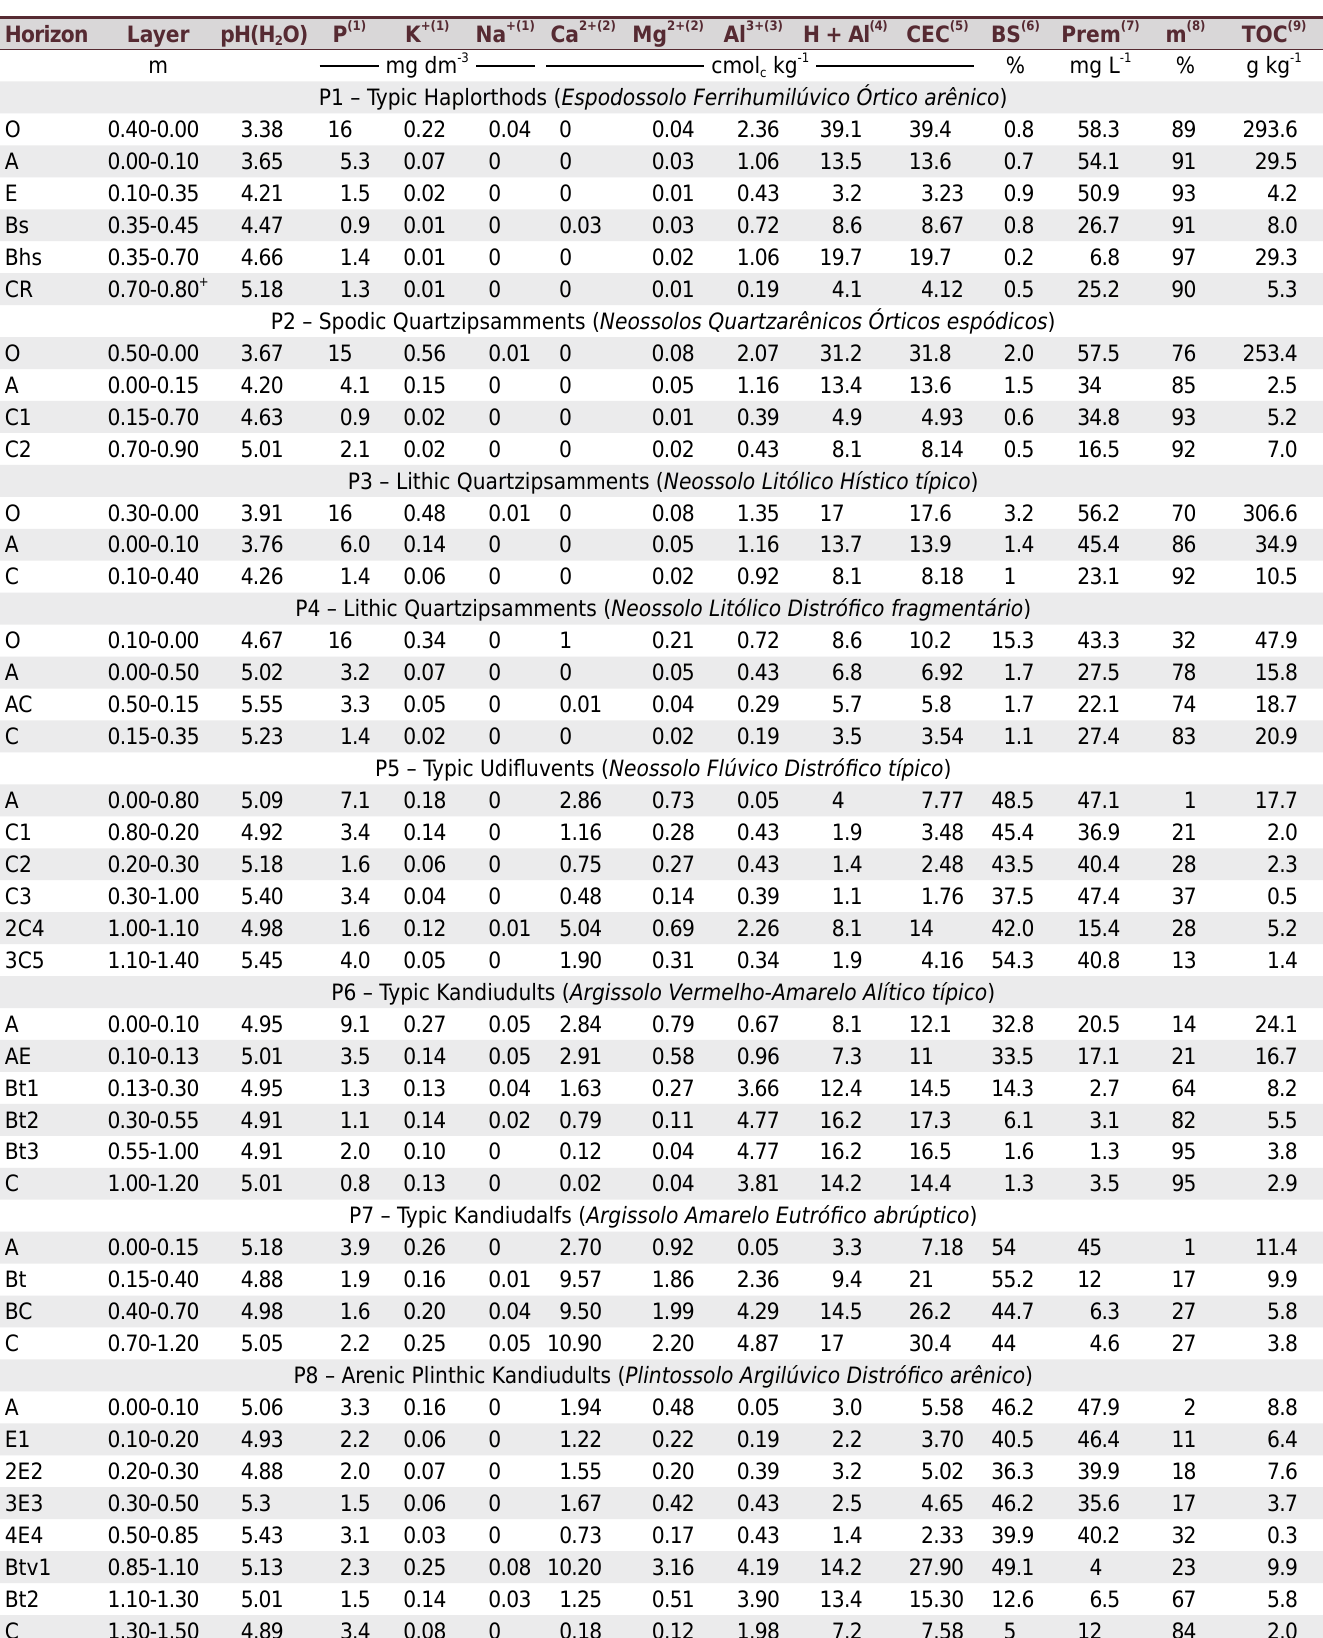
Table 4. Chemical characteristics of the <2 mm fraction of the studied soils Horizon Layer